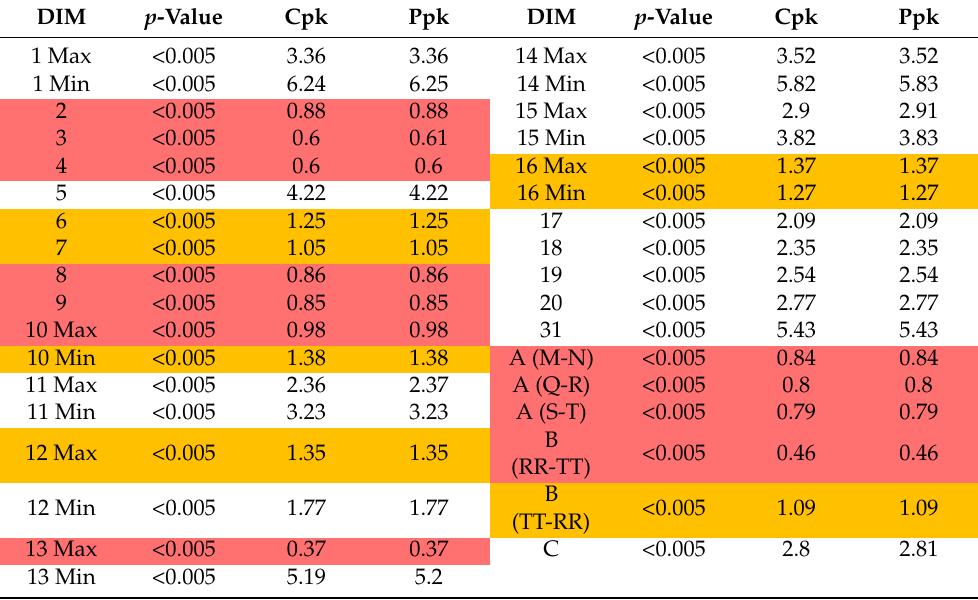
Figure 13. Plot of capability index for all DIMs. Thorough analysis of the capability index showed that only 11 DIMs have low capa- bility (capability index ≤ 1), which accounts for 31.4% of the total 35 DIMs. Only seven DIMs showed good capability (1 < capability index ≤ 1.67). The DIMs with low capability were analyzed on a case-by-case basis and the following conclusions were derived after discussion with the process engineers: DIM 2 and 10 MAX had an outlier, DIM 13 MAX had very narrow limits which made it a critical dimension, DIM 3, 4, 9, and B (RR-TT) might have had the wrong machine setup and plenty of variation was observed for DIM 8, A (M-N), A (Q-R), and A (S-T) due to unknown reasons. The histograms for the 11 DIMs with low capabilities are shown in Figure 14.